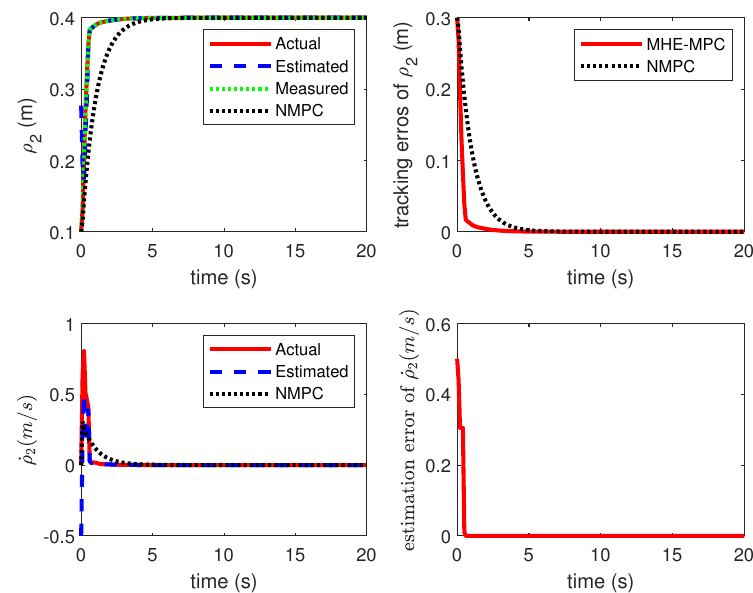
Figure 5. Case 1: state variables ρ 2 , ˙ ρ 2 and their tracking/estimation errors.